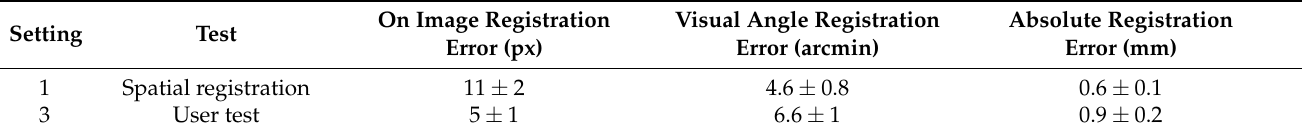
Table 2. Spatial registration